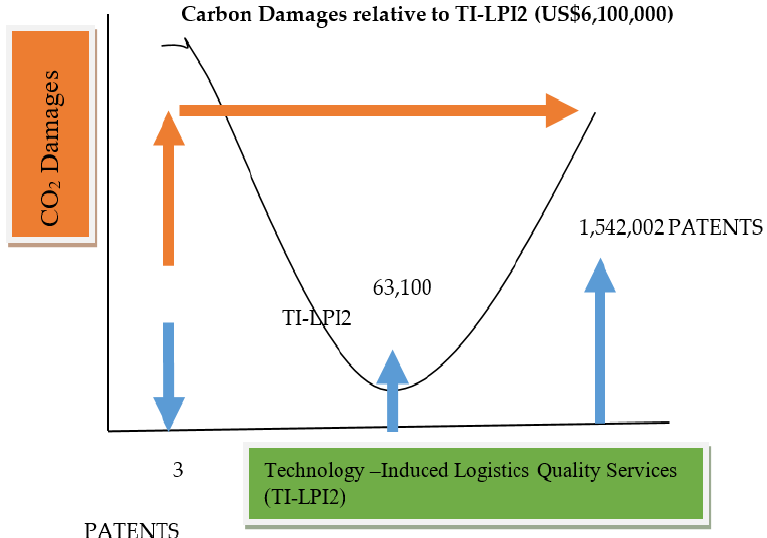
Figure 7. Moderation U-shaped Curve between Carbon Damages and Technology Induced Logistics Performance Indices (LPI2 × PATENTS).